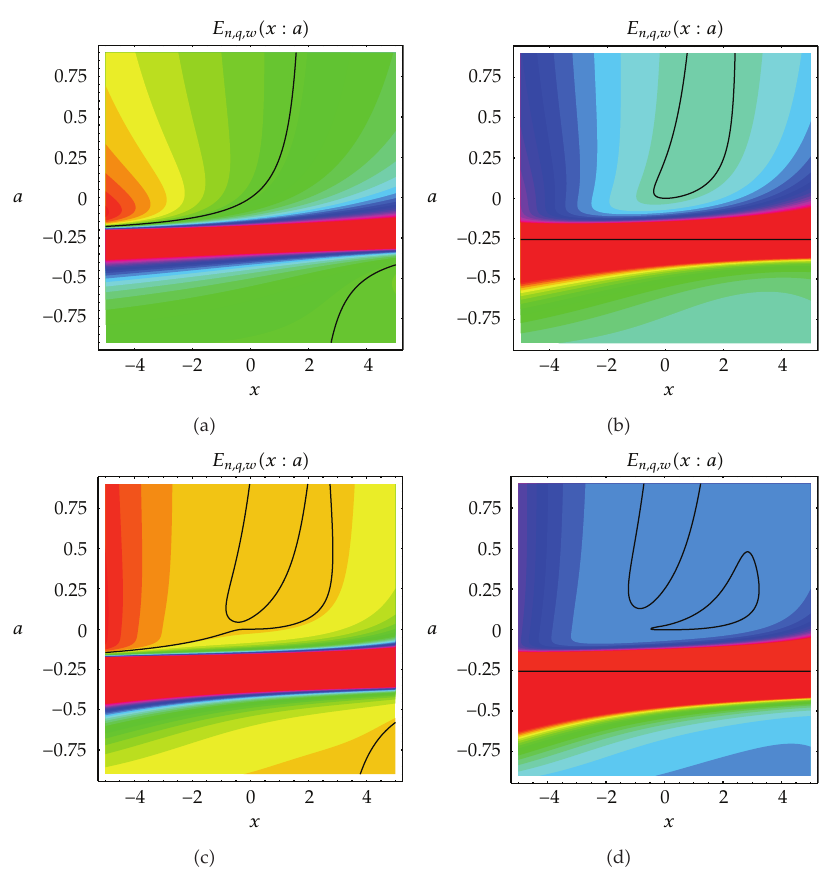
Figure 5: Zero contour of E n,q,w (cid:2) x : a (cid:3)